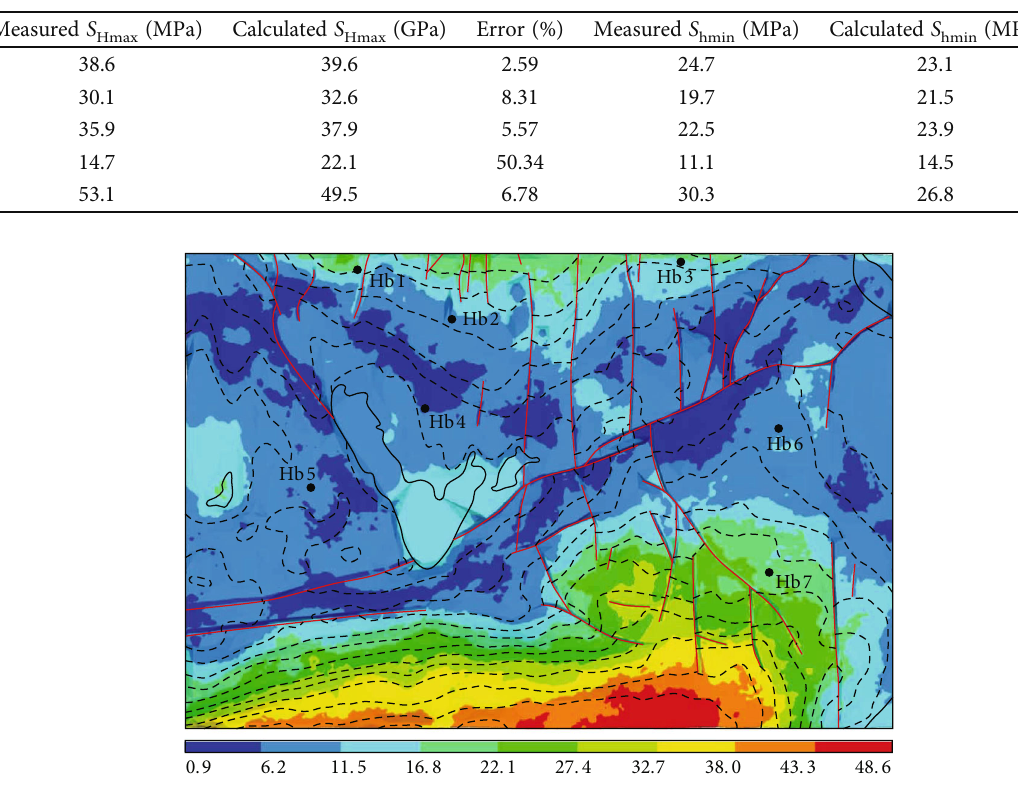
Figure 9: Di ff erential stress in the Longmaxi Formation of Haiba Block Stress (unit: MPa).